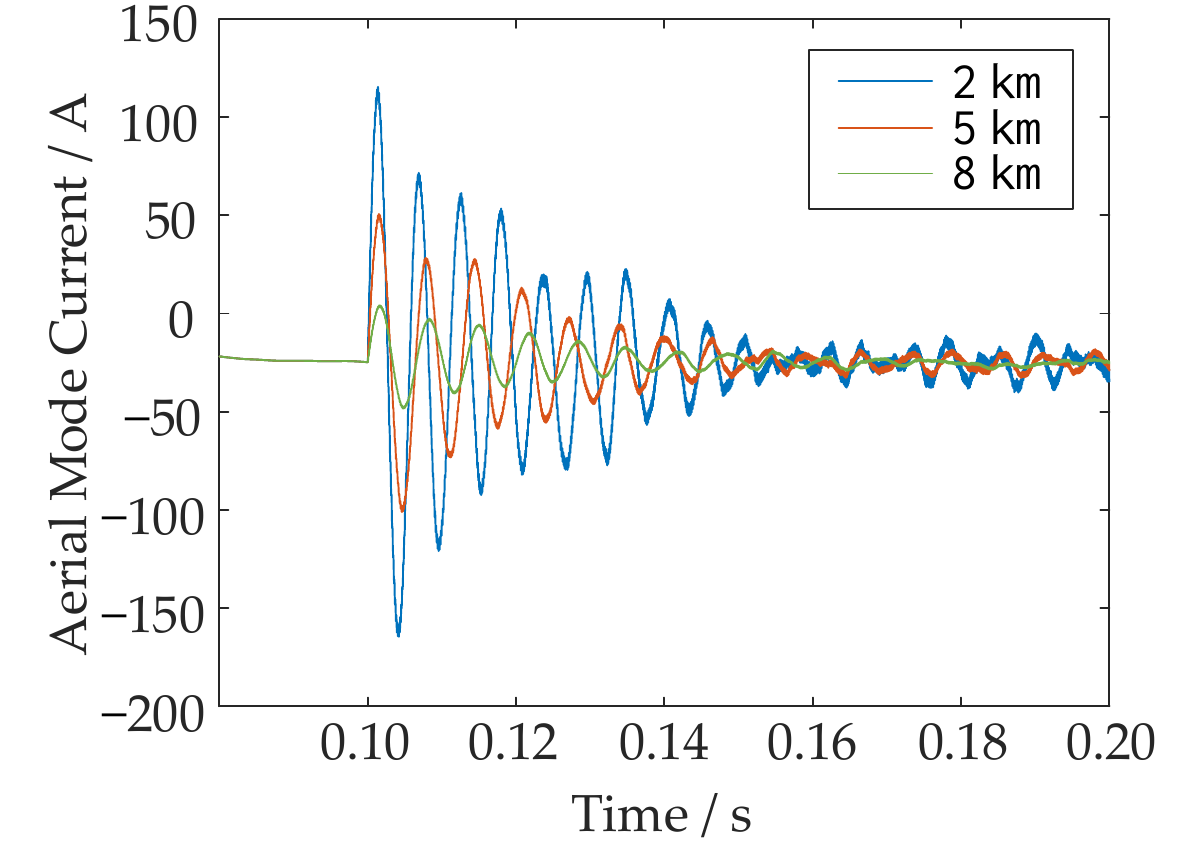
Figure 3. Aerial mode current for monopolar grounding in different positions.